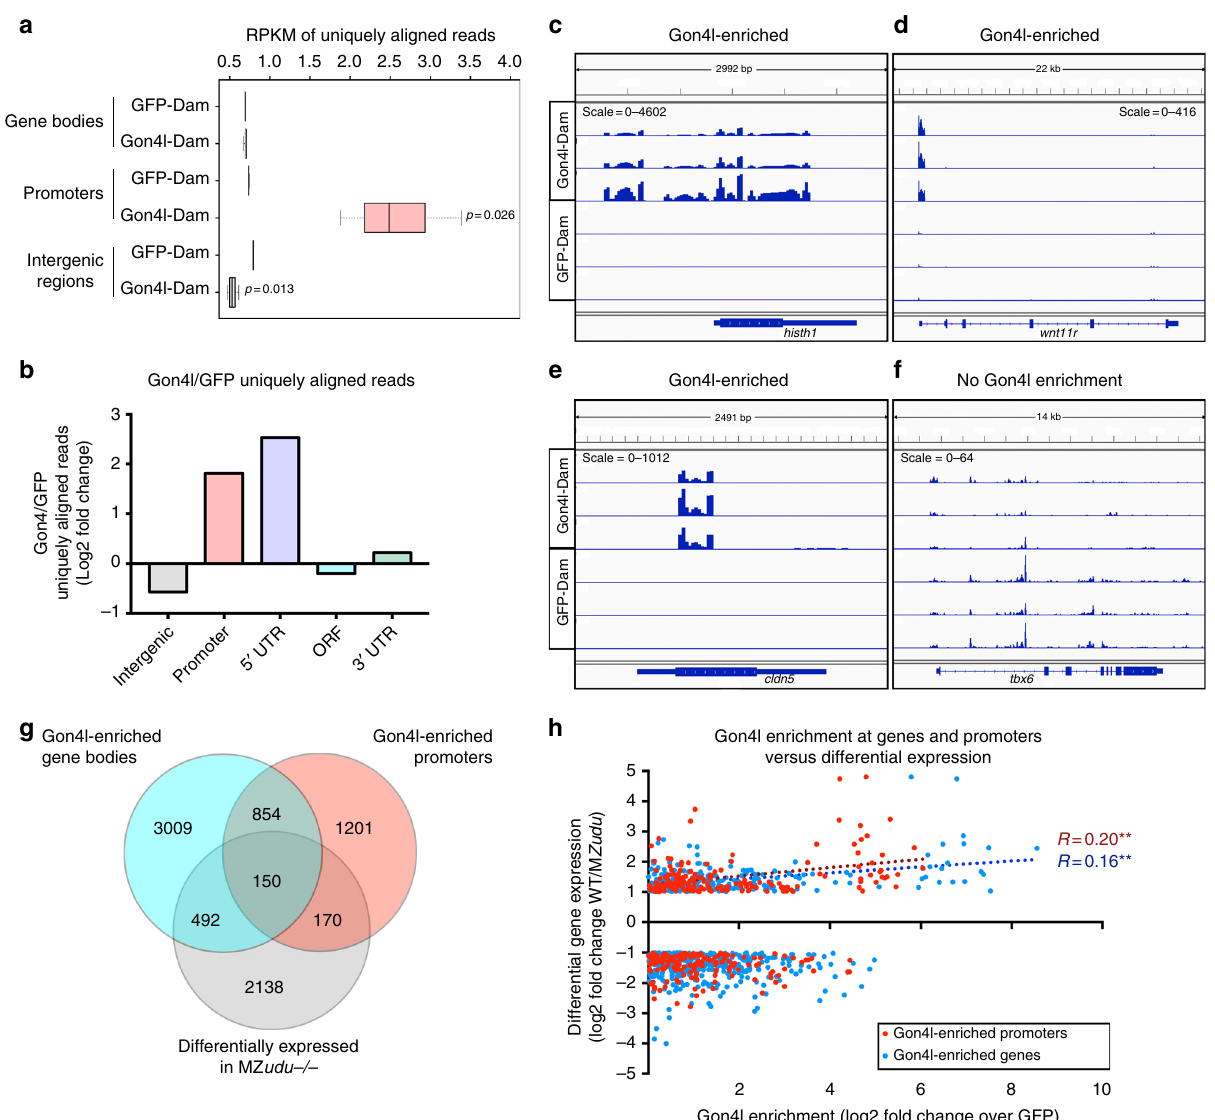
Fig. 6 DamID-seq identi fi es putative direct targets of Gon4l during gastrulation. a Box plot of normalized uniquely aligned DamID reads at each of three categories of genomic regions. Center lines are medians, box limits are upper and lower quartiles, whiskers are highest and lowest values. P -values indicate signi fi cant differences between Gon4l-Dam samples and GFP-Dam controls ( T -test). b Fold change (log2) Gon4l-Dam over GFP-Dam reads (RPKM) at each of fi ve gene features. c – f Genome browser tracks of Gon4l-Dam and GFP-Dam association at the histh1 ( c ), wnt11r ( d ), cldn5 ( e ), and tbx6 ( f ) loci. Scale is number of reads. Each track represents one biological replicate at tailbud stage. g Venn diagram of genes with regions of signi fi cant Gon4l enrichment within gene bodies (blue) or promoters (pink), and genes differentially expressed in MZ udu − / − gastrulae (gray). h Correlation of Gon4l enrichment levels across gene bodies (blue dots) and promoters (red dots) with relative transcript levels of genes differentially expressed in MZ udu mutants. A positive correlation was detected between increased expression in WT relative to MZ udu mutants and Gon4l enrichment in both gene bodies (Spearman correlation p = 0.0095) and promoters ( p = 0.0098). Dotted lines are linear regressions of these